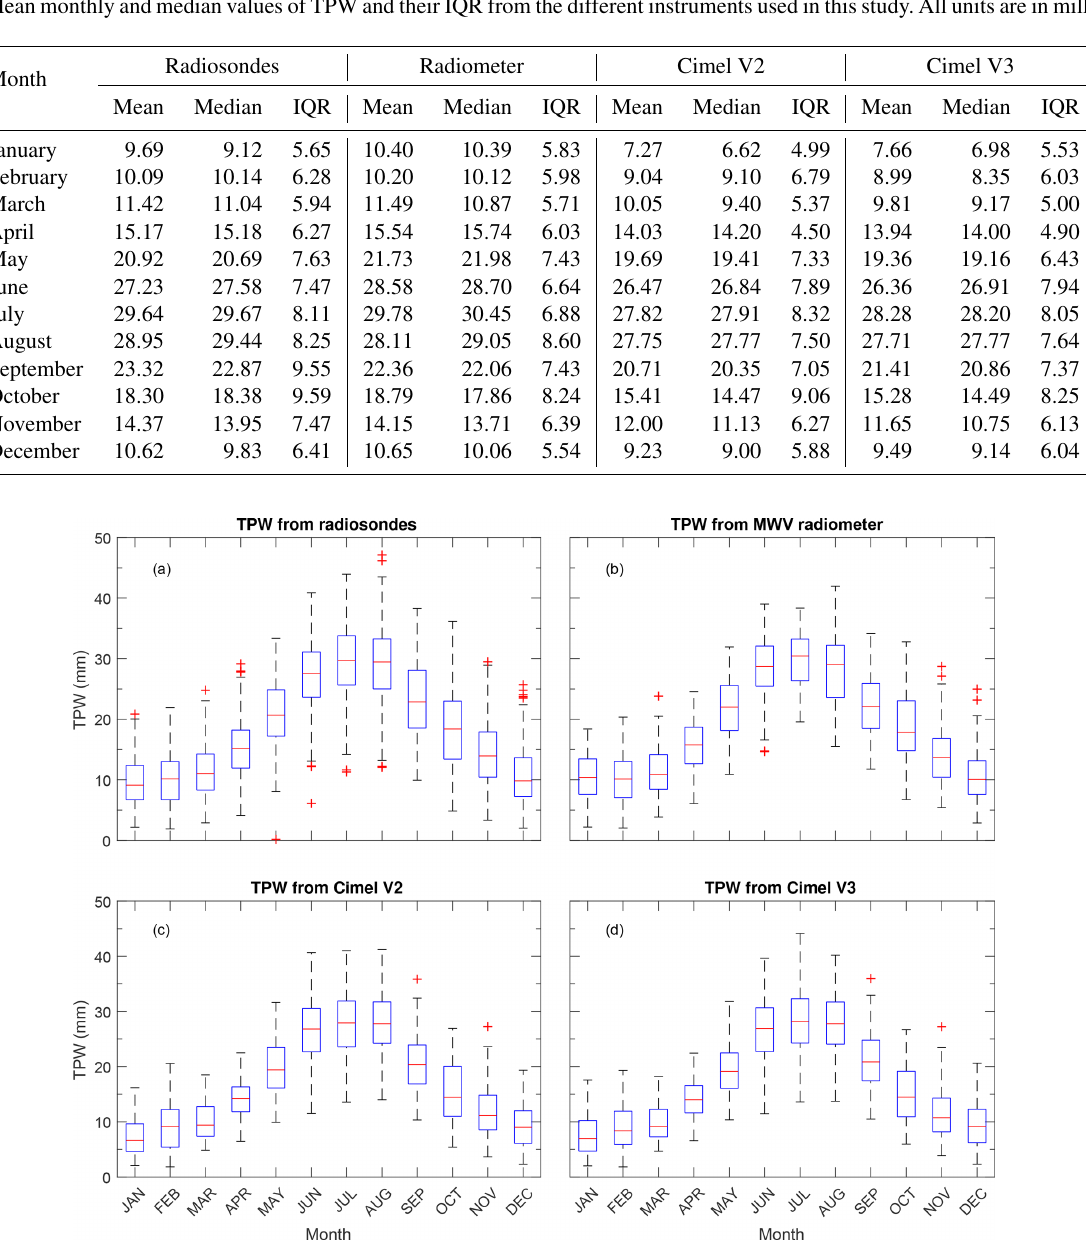
Figure 3. Monthly variation in total precipitable water from (a) radiosondes during the period 2007–2017, (b) microwave radiometer during the period 2009–2017, (c) Cimel sun photometer version 2 data and (d) Cimel sun photometer version 3 data for the period 2007–2016. The median values are shown as the red lines, the interquartile range (IQR) is spanned by the vertical bars and the whiskers show the 1.5 IQR. The red + symbols show the outliers in the